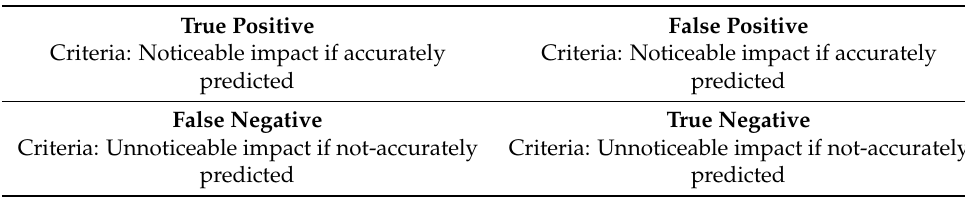
Table 2. Confusion Matrix (2 ×